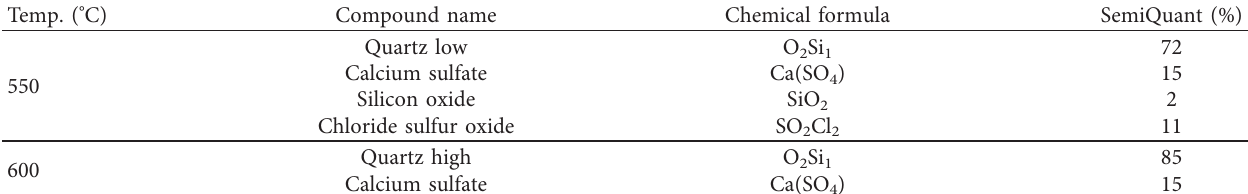
Table 6: XRD analysis of BD-1A ash.